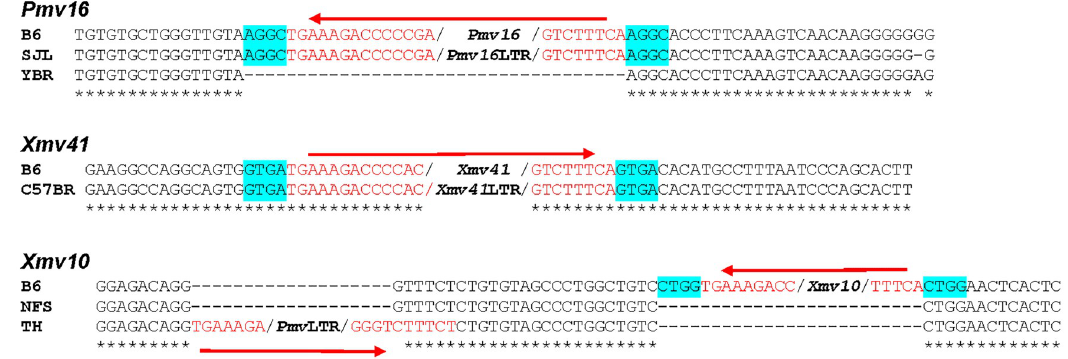
Fig 5. Solo LTRs at insertion sites of Pmv16 , Xmv41 and Xmv10 . ERV sequences are in red. Flanking sequences of Pmv16 and Xmv41 show target site duplications, highlighted in blue, and these LTRs are at the same sites as the corresponding ERV in B6 mice. There is a Pmv -like solo LTR adjacent to the Xmv10 site in TH mice; NFS is representative of strains that lack this LTR and Xmv10